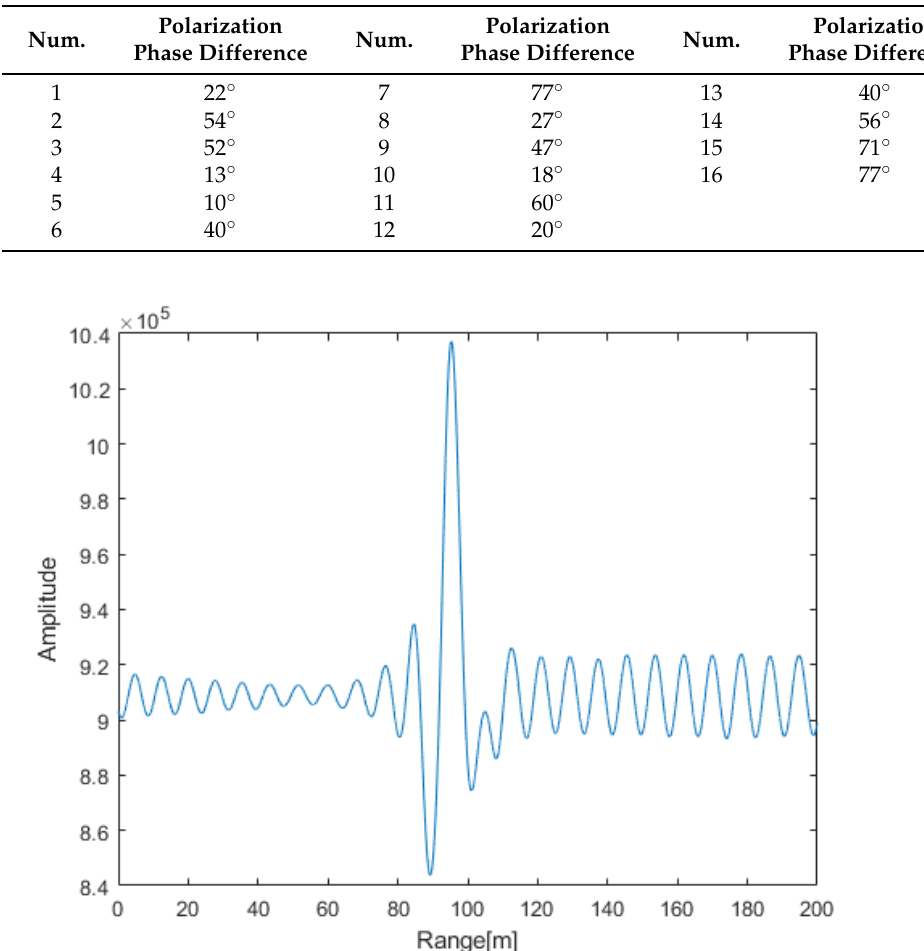
Figure 7. Pulse compression results of the horizontal received